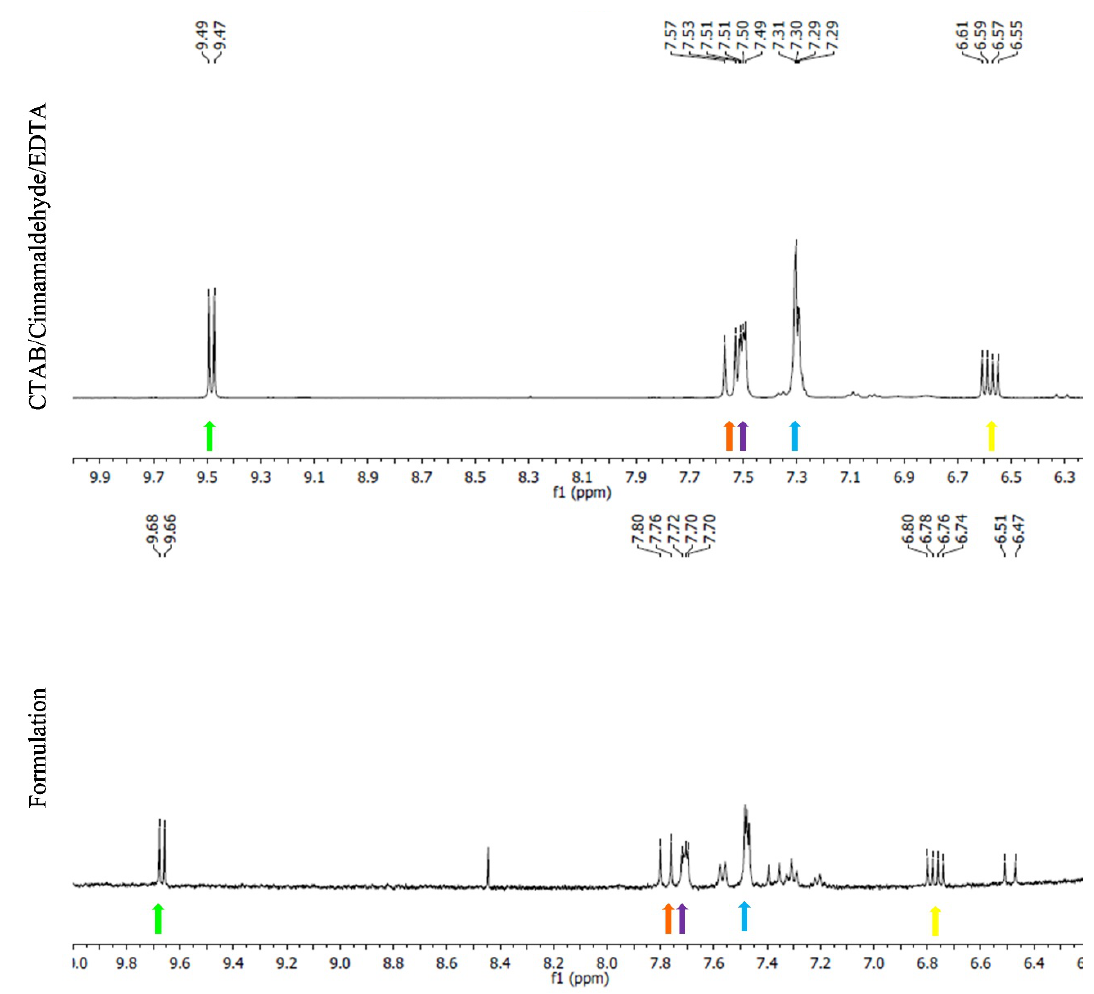
Figure 7. 1 H NMR spectra of cinnamaldehyde (top), a mixture of CTAB-cinnamaldehyde-EDTA in water (middle), and the formulation (bottom). All the solutions were prepared in deuterated water.